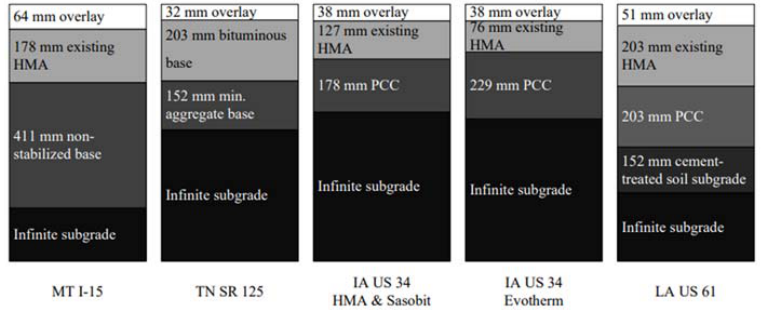
Figure 1. Pavement structure diagram of each project. (From top to bottom in turn are overlay, existing HMA, base, and subgrade respectively.)